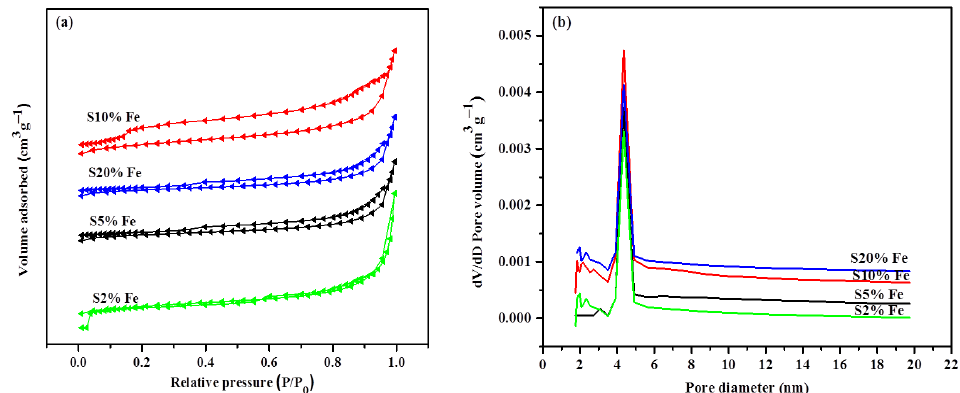
Figure 5. ( a ) N 2 adsorption–desorption isotherms and ( b ) pore-size distribution of catalytically- graphitized few-layer graphene samples with different Fe loadings.